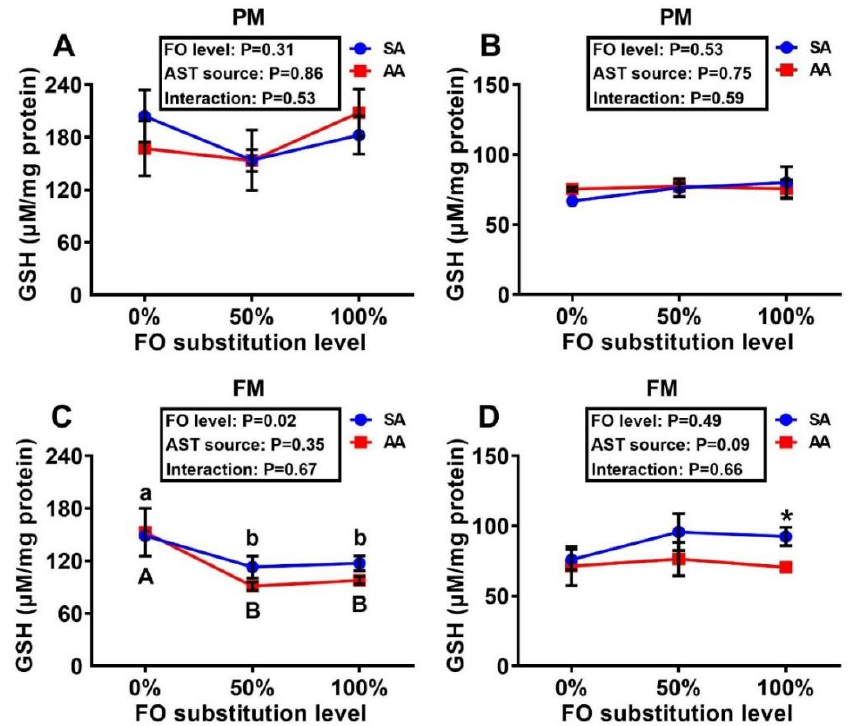
Figure 3. Effects of dietary fish oil substitution by DHA-rich microalgae and source of astaxanthin on MDA concentrations in the muscle (fillet, A , C ) and liver ( B , D ) of juvenile rainbow trout fed the plant meal- (PM, A , B ) and fishmeal (FM, C , D )-based diets. Means labelled with different letters [lowercase (a, b), synthetic astaxanthin (SA) groups] are different between various fish oil substi- tutions ( p < 0.05). Asterisks ( * ) indicate differences between the SA and AA groups ( p < 0.05) at the same level of FO substitution. The absence of different letters (a, b) or asterisks ( * ) between means indicates no significant differences. MDA: malondialdehyde. FO: fish oil. AST: astaxanthin.